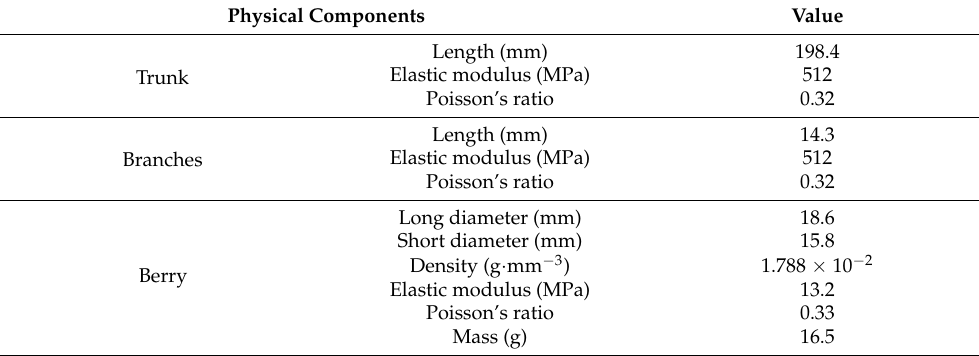
Table 2. Parameter settings, such as Poisson’s ratio.